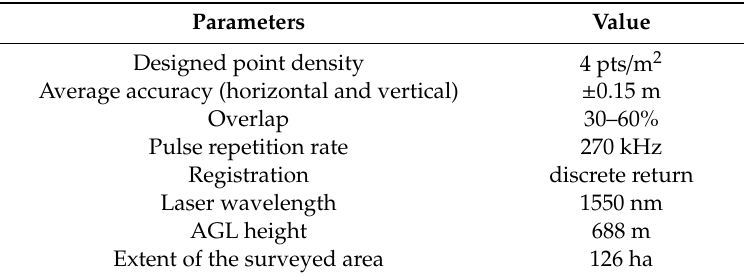
Table 1. The parameters of the survey.